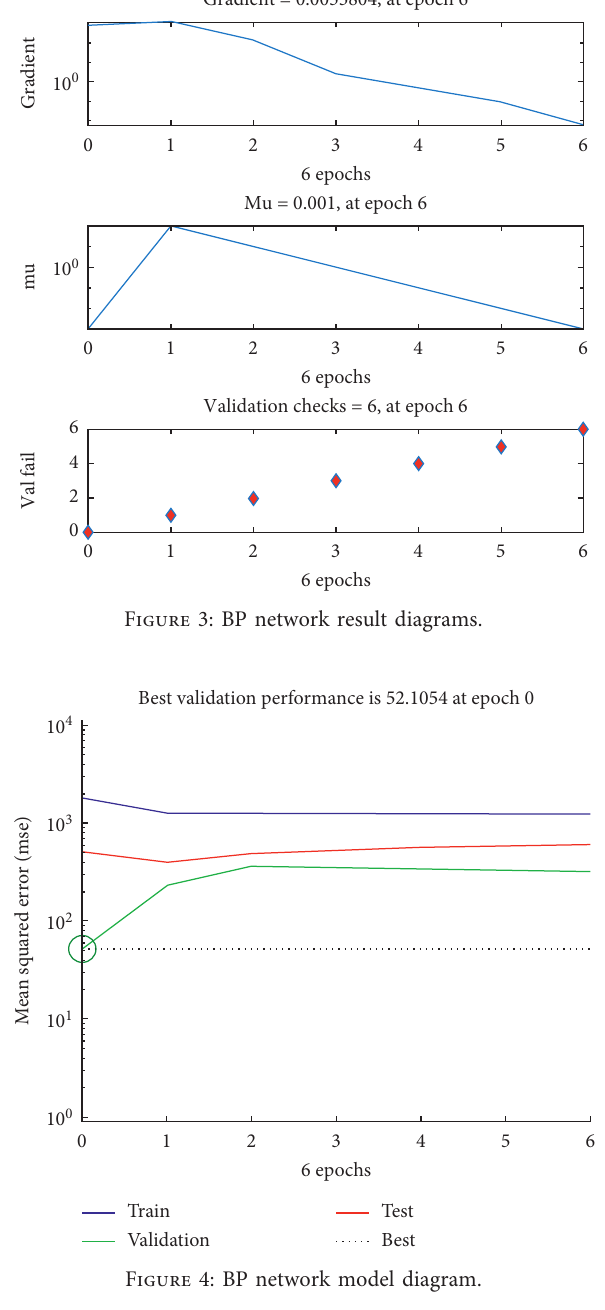
Figure 4: BP network model